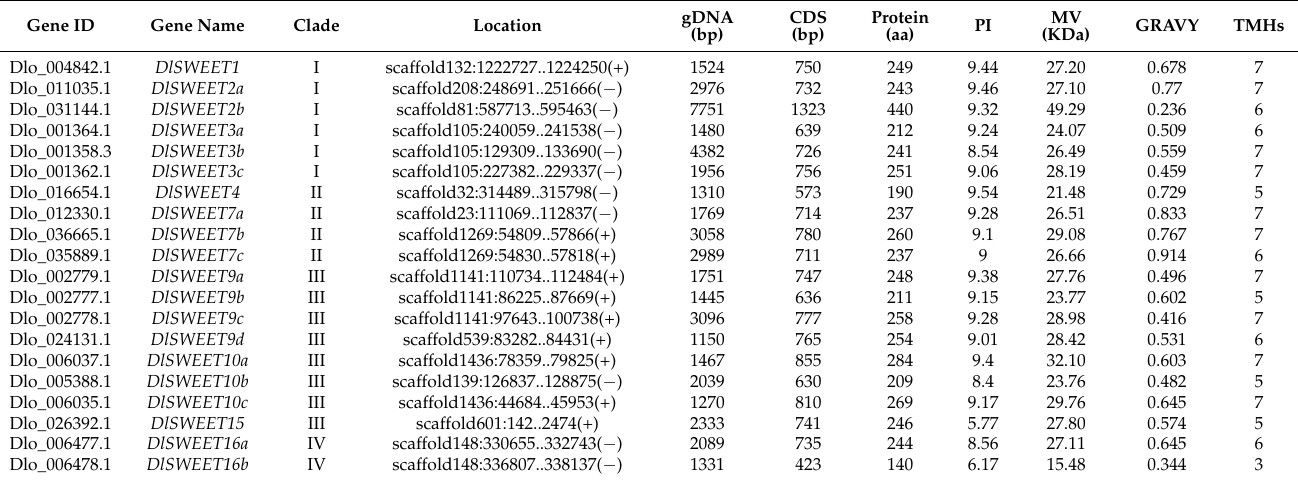
Table 1. Characteristics of 20 DlSWEET